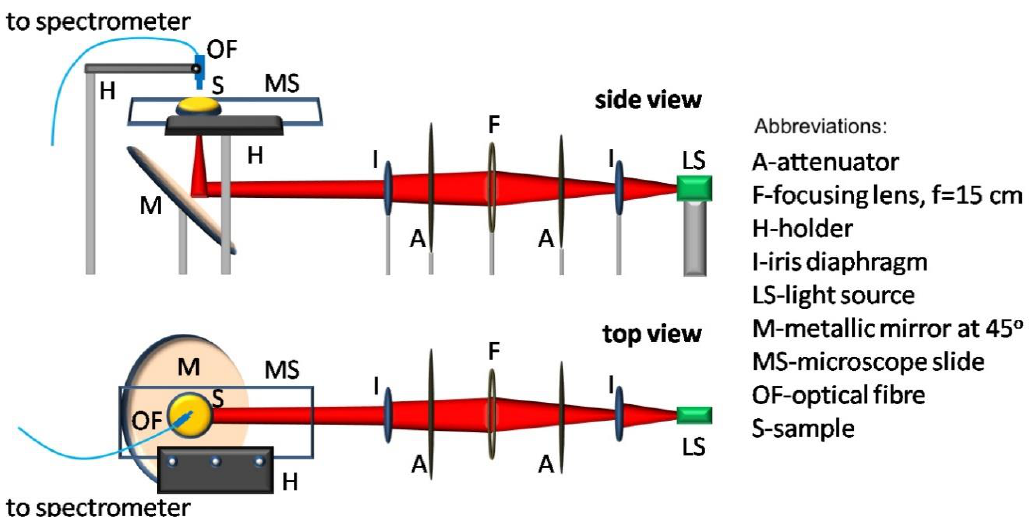
Figure 1. Experimental set-up for the spectrophotometry measurements performed on dental bleaching gels.